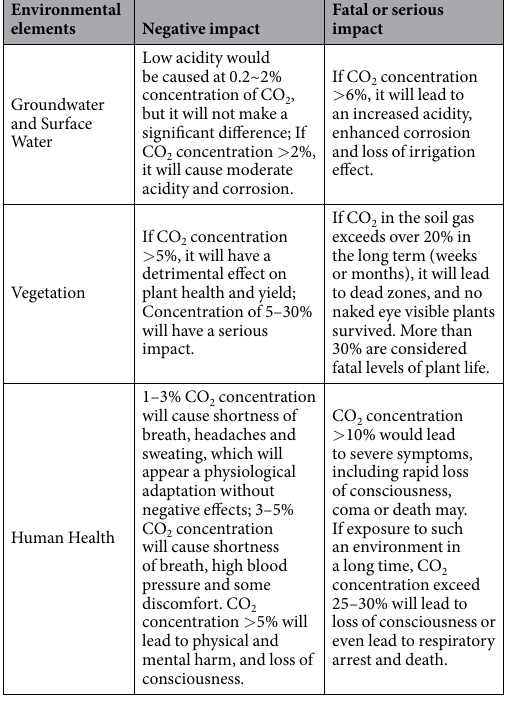
Table 1. Main environmental elements impacted by CO 2 geological